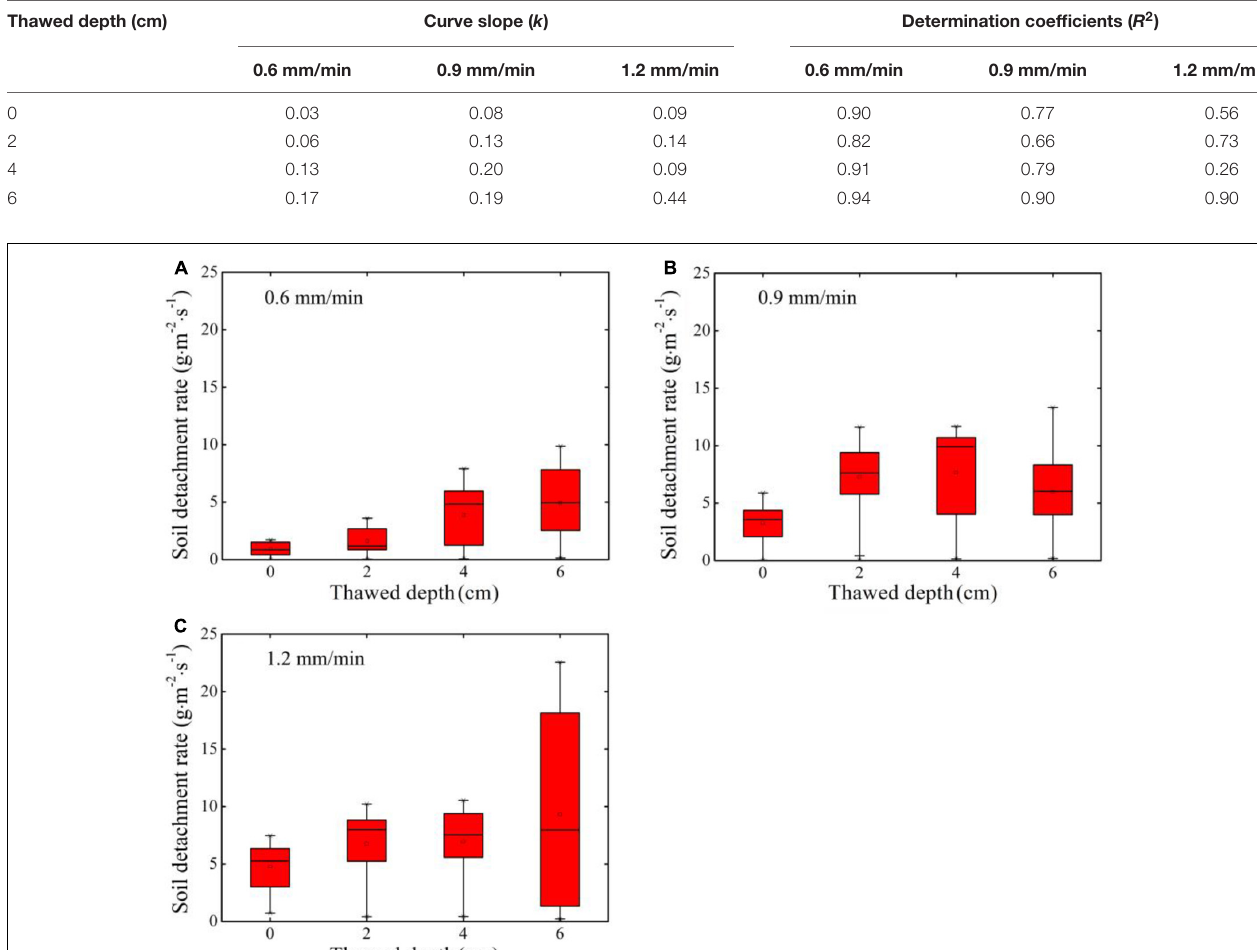
TABLE 1 | Regression parameters of erosion processes under different thawed depth and rain intensity. Thawed depth (cm) Curve slope ( k )